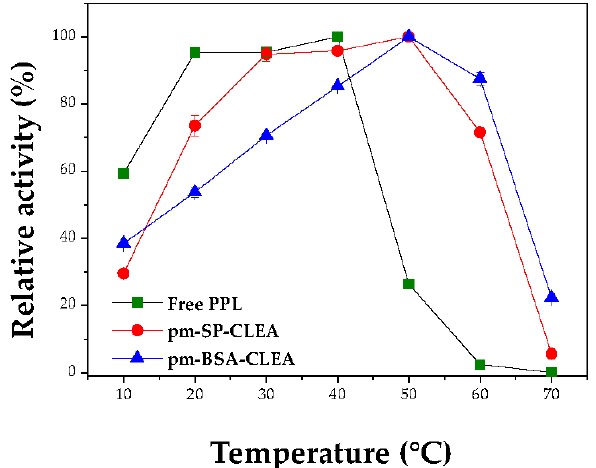
Figure 7. Activity profiles of PPL vs. temperature. pm-(BSA or SP)-CLEA preparation conditions: treatment of PPL surface with dodecyl aldehyde (PPL/dodecyl aldehyde mass ratio of 1:1), aggregation/precipitation with ethanol (enzyme solution/ethanol volume ratio of 1:3) in presence of PPL/BSA/SMNPs or PPL/SP/SMNPs mass ratio of 1:1.5:1.5 and starch (0.8% w / v ) for 0.5 h, followed by treatments with glutaraldehyde (5 μ moles of glutaraldehyde/mg total protein) for 15 h at 4 °C under 150 rpm stirring, and with α -amylase at 25 °C under 150 rpm stirring for 2 h. Activity assay: hydrolysis of tributyrin solution pH 8.0 (217.9 mM concentration), temperature ranging from 10 to 70 °C for 5 min under 500 rpm stirring.